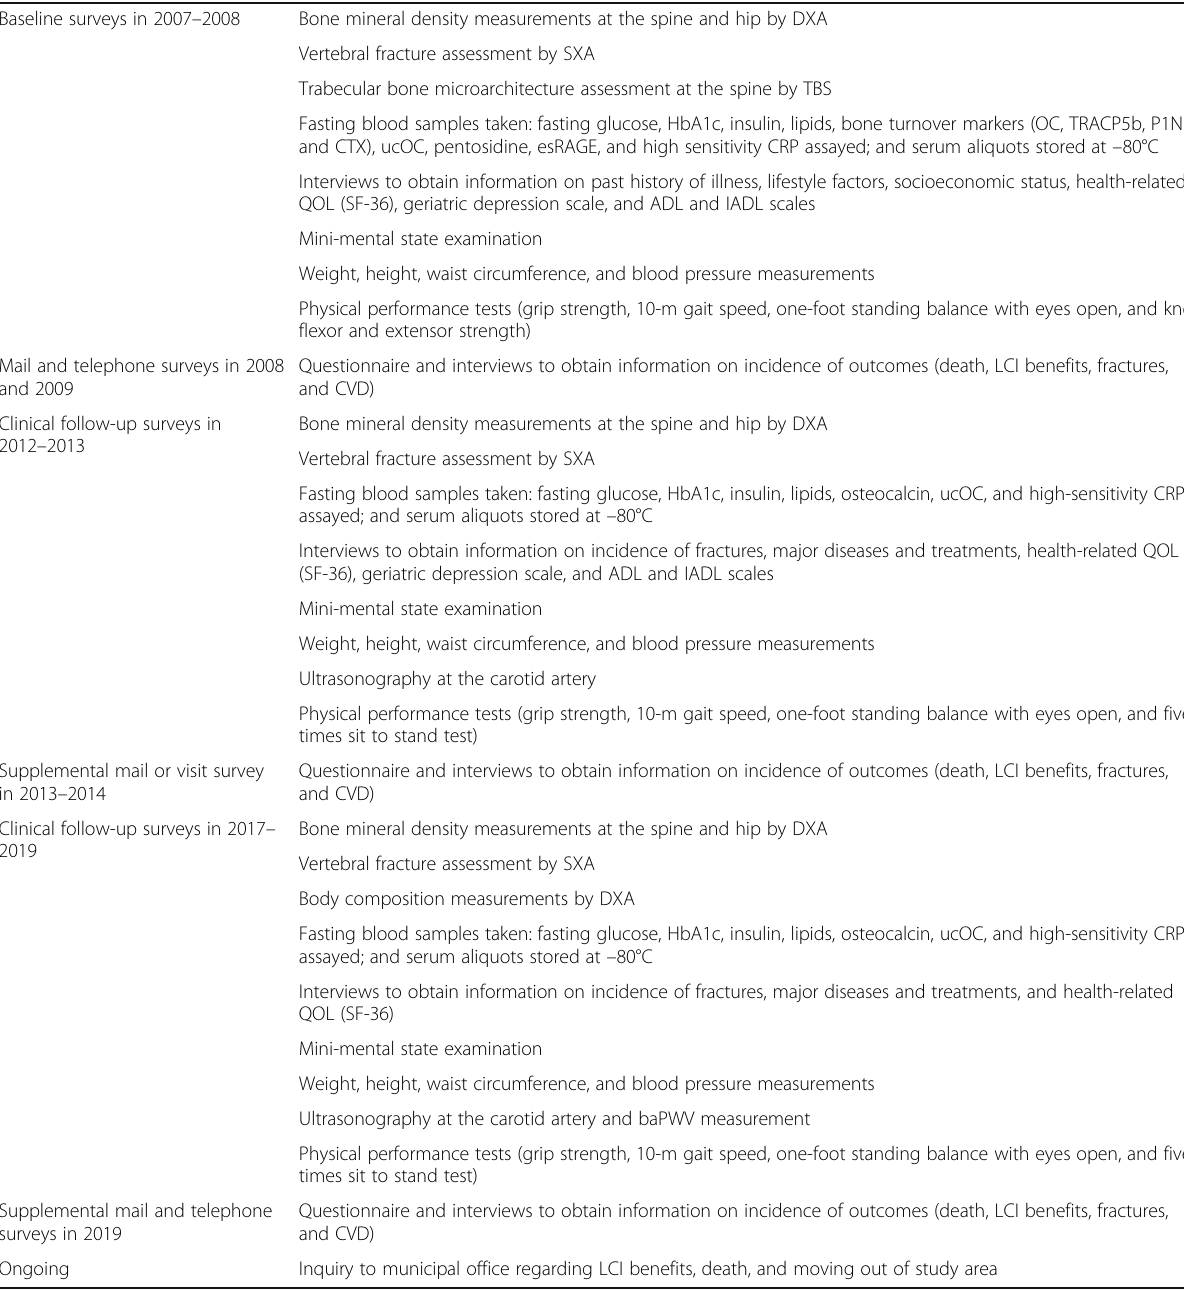
Table 1 Study measurements conducted in each phase of the FORMEN study Phase